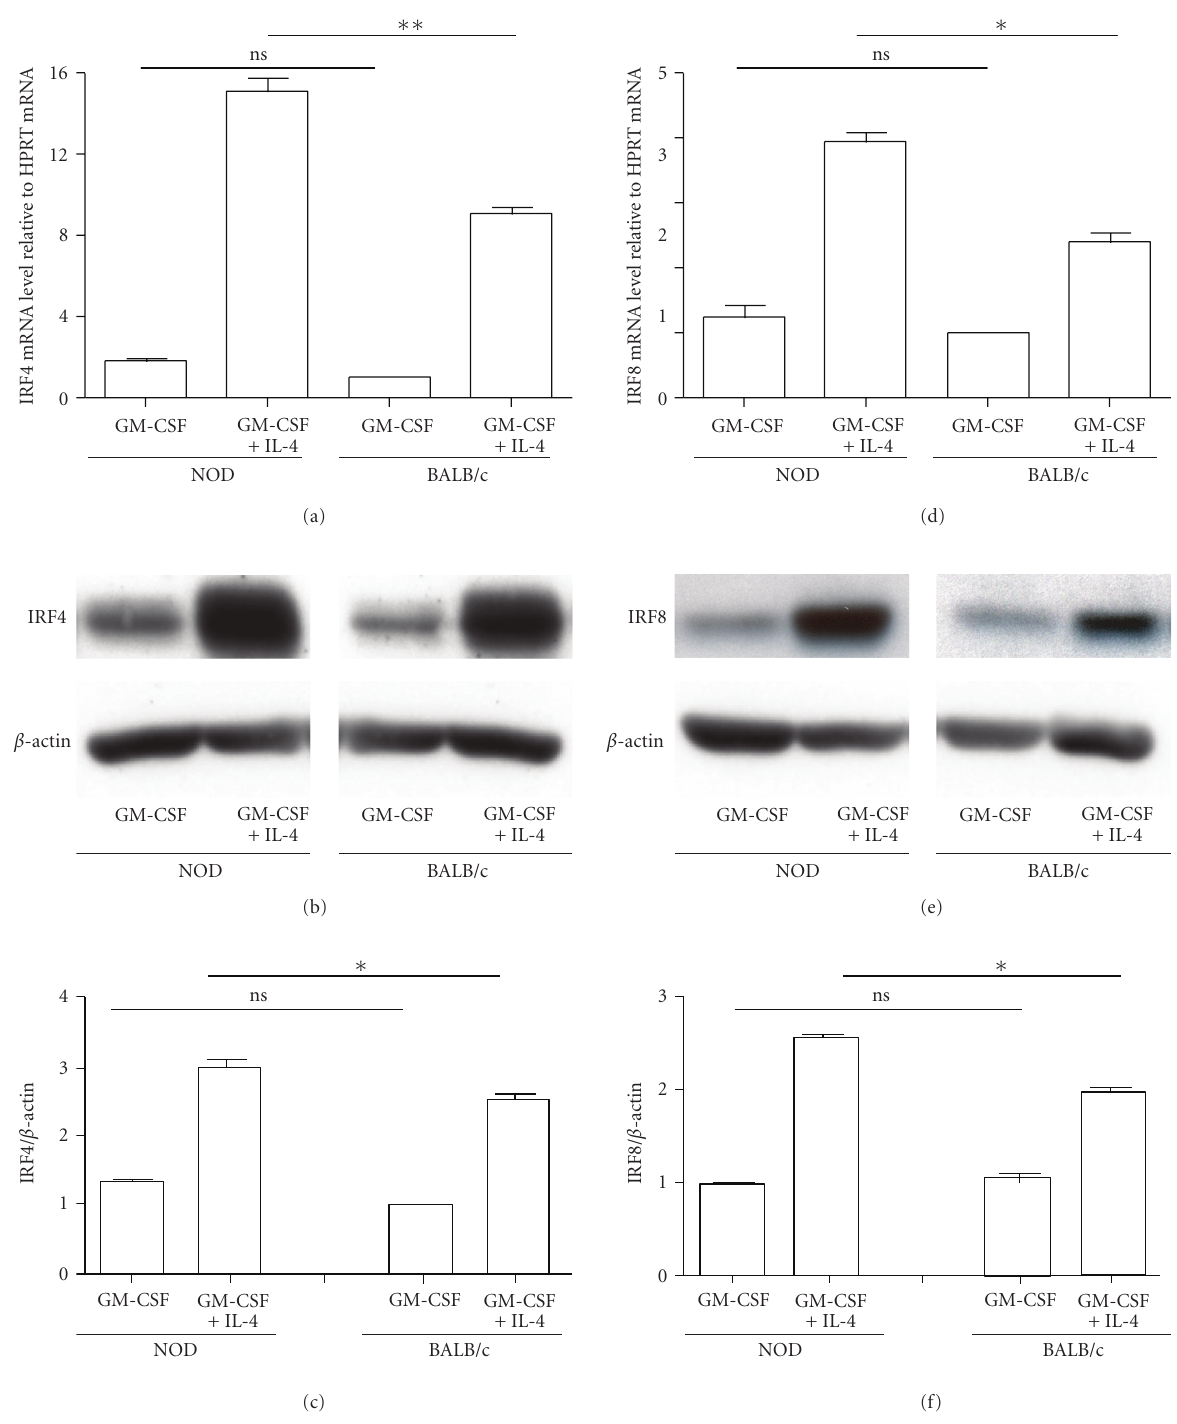
Figure 4: Reduced expression of IRF4 and IRF8 in tolerogenic BMDCs derived from NOD mice. Total RNA was extracted from BM-DCs generated with GM-CSF or a combination of GM-CSF and IL-4, purified and gene expression profiles of IRF4 (a) and IRF8 (d) were analyzed by RT-PCR. Each sample was analyzed in triplicates and normalized to HPRT expression ( Δ Ct). Each NOD sample was normalized to BALB/c sample ( ΔΔ Ct = Δ Ct sample − Δ Ct BALB/c), and the expression levels were calculated as follows: 2 − ΔΔ Ct . Data are shown as the average ± SD of 3-4 independent experiments ( ∗ P < . 05 and, ∗∗ P < . 01). (b) and (e) total proteins were extracted from BM-DCs generated with GM-CSF or a combination of GM-CSF and IL-4 and analyzed by Western blotting for IRF4 (b) or IRF8 (f) expression. The relative intensities of bands were assessed using the NIH Image software and normalized to reference actin bands to establish a ratio of (c) IRF4/actin and (f) IRF8/actin. The expression levels observed in BALB/c mice were arbitrarily set as a unitary value. A representative of 2 independent experiments is shown. Error bars correspond to